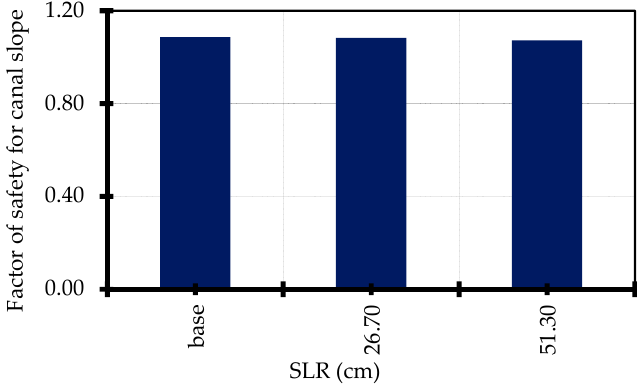
Figure 16. Canal factor of safety for rise in sea level by 26.70 and 51.30 cm.